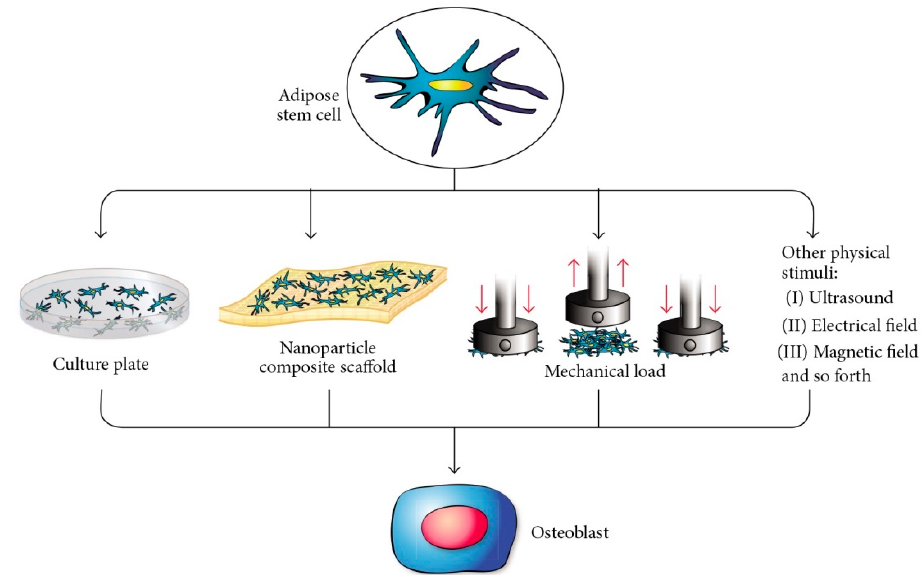
Figure 7. Schematic illustration of various stimulating factors affecting the differentiation ASCs towards osteoblasts. With permission from Reference [206] .